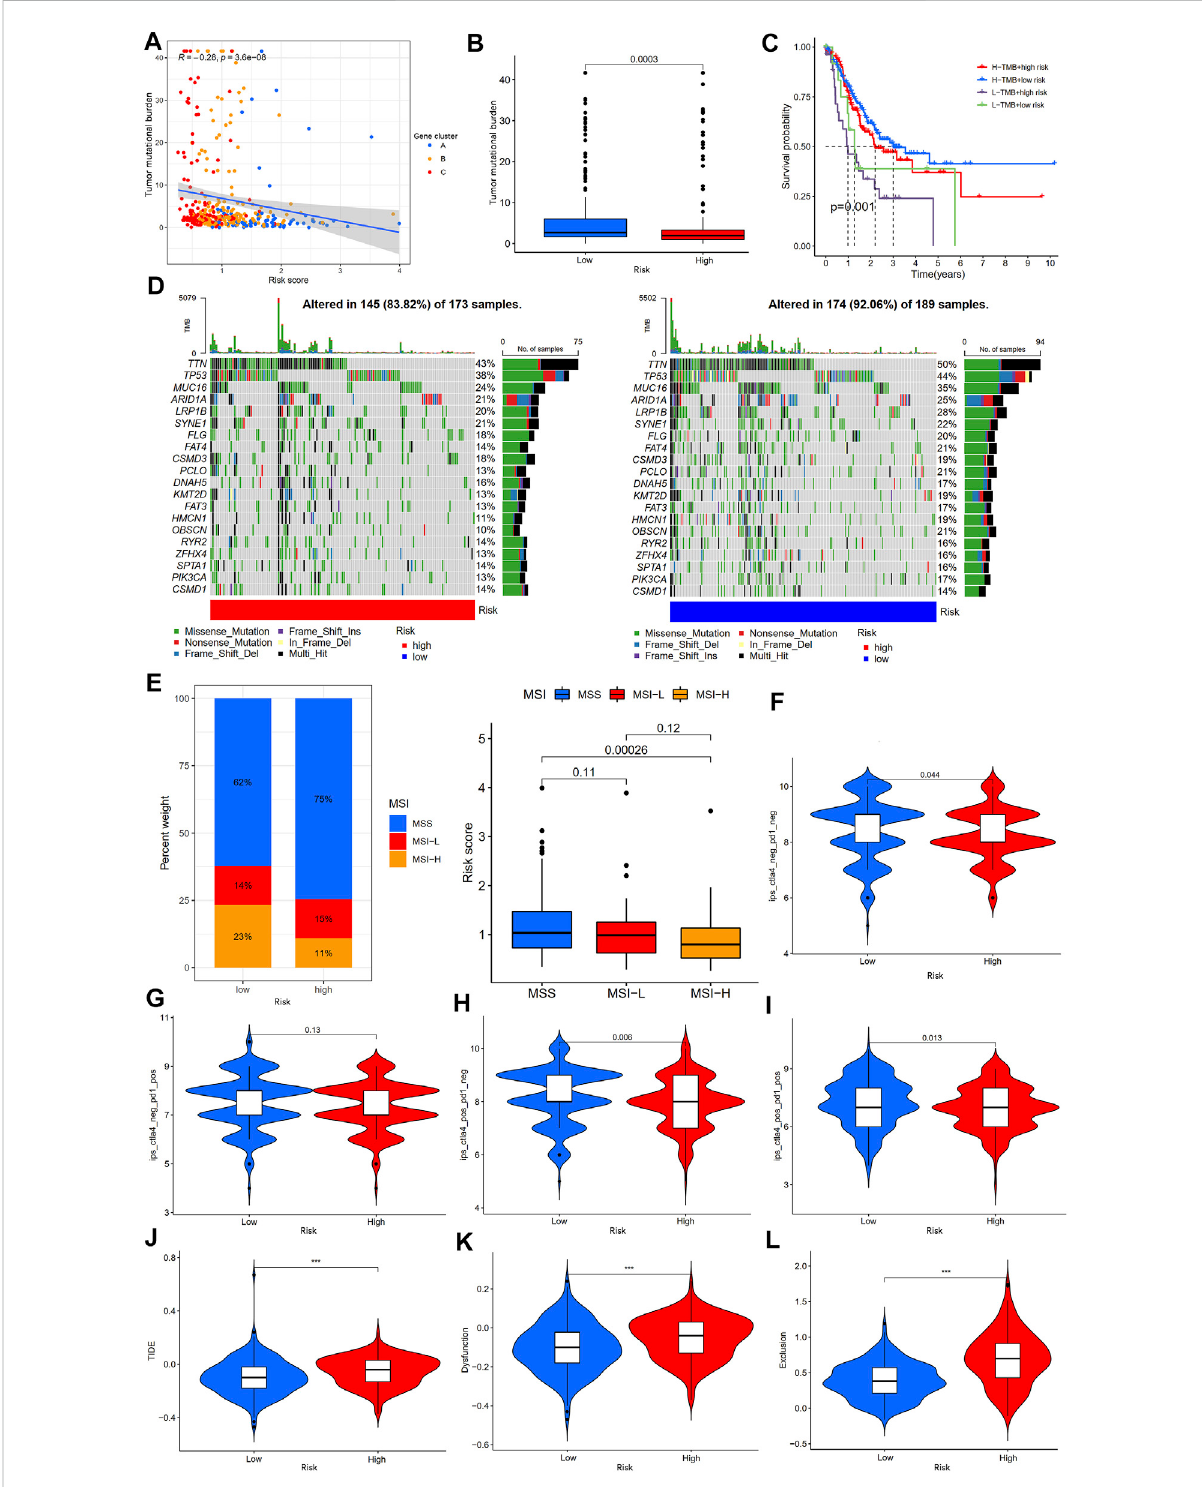
FIGURE 11 Analysis of immunotherapy response rates between high- and low-risk groups. (A) Spearman correlation analysis of the risk score and TMB. (B) Analysis ofTMB differencesbetweenhigh- andlow-risk groups. (C) Kaplan-Meier survival analysis amongfour subgroups strati fi edbyboth TMB and risk score. (D) The waterfall plot of somatic mutation landscape high- and low-risk groups. (E) Relationships between risk score and MSI. (F) The ips_ctla4_neg_pd1_neg, (G) ips_ctla4_neg_pd1_pos, (H) ips_ctla4_pos_pd1_neg, and (I) ips_ctla4_pos_pd1_pos analyses between the high- and low-risk groups. (J – L) The TIDE, dysfunction, and exclusion score analyses between the high- and low-risk groups. TMB, tumor mutation burden; IPS, immunophenoscore; TIDE, tumor immune dysfunction and exclusion; ***p <